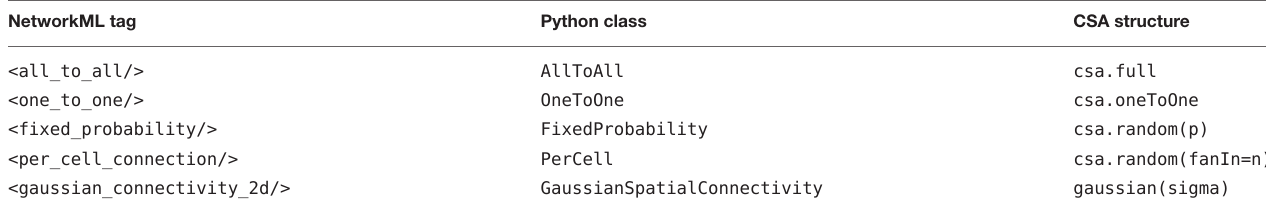
TABLE 1 | XML connectivity pattern tags and their corresponding Python classes and CSA